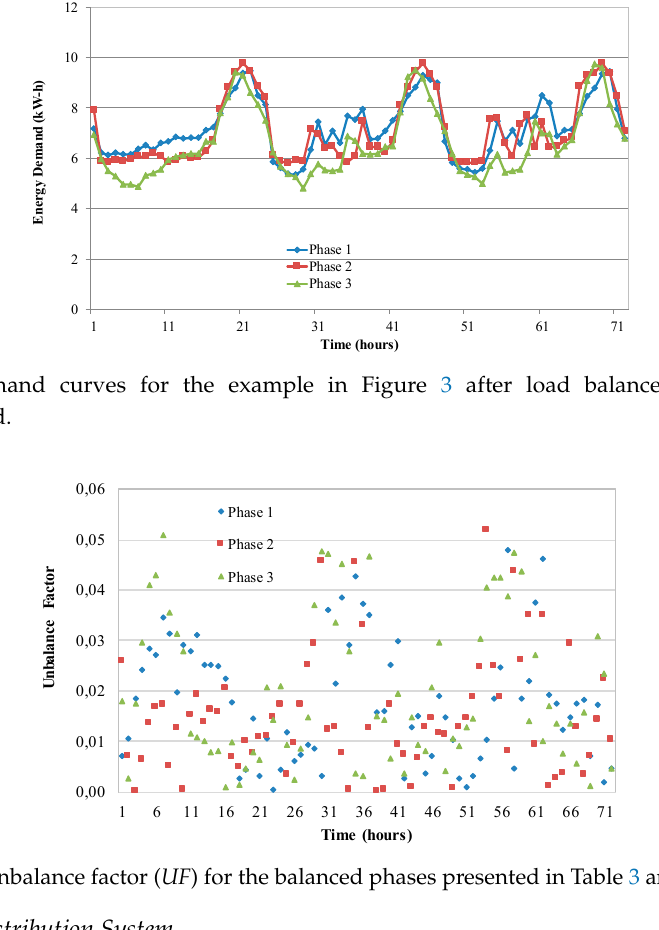
Figure 6. Unbalance factor ( UF ) for the balanced phases presented in Table 3 and Figure 5.